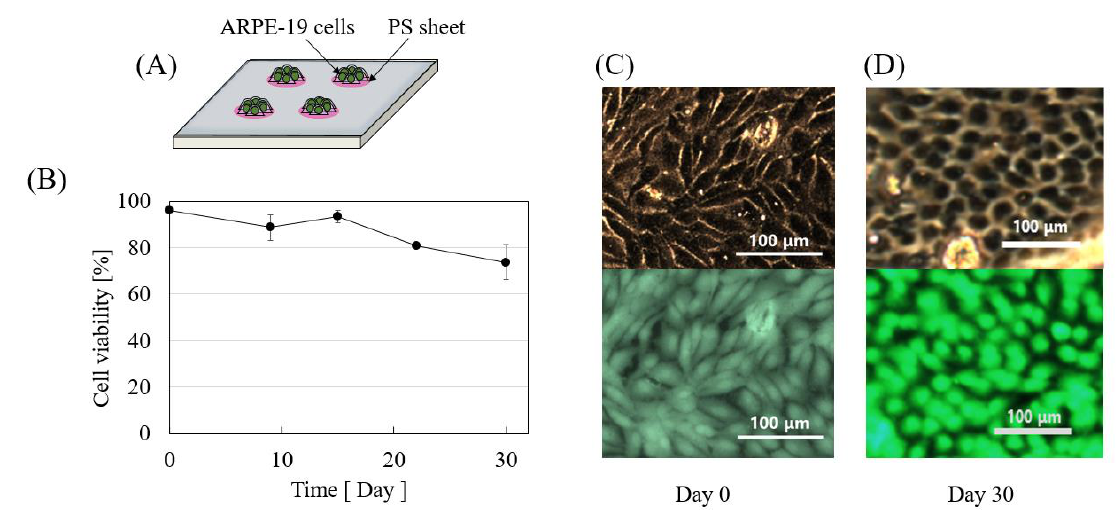
Figure 4. Cellular viability of ARPE-19 cells in collagen coated PS sheets. ( A ) Cells were cultured on collagen coated 5 mm diameter PS sheets. ( B ) ARPE-19 cells maintain over 75% cell viability for at least 30 days on the PS sheet (n = 3). Morphology of confluent monolayer cells are similar for both ( C ) day 0 and ( D ) day 30.